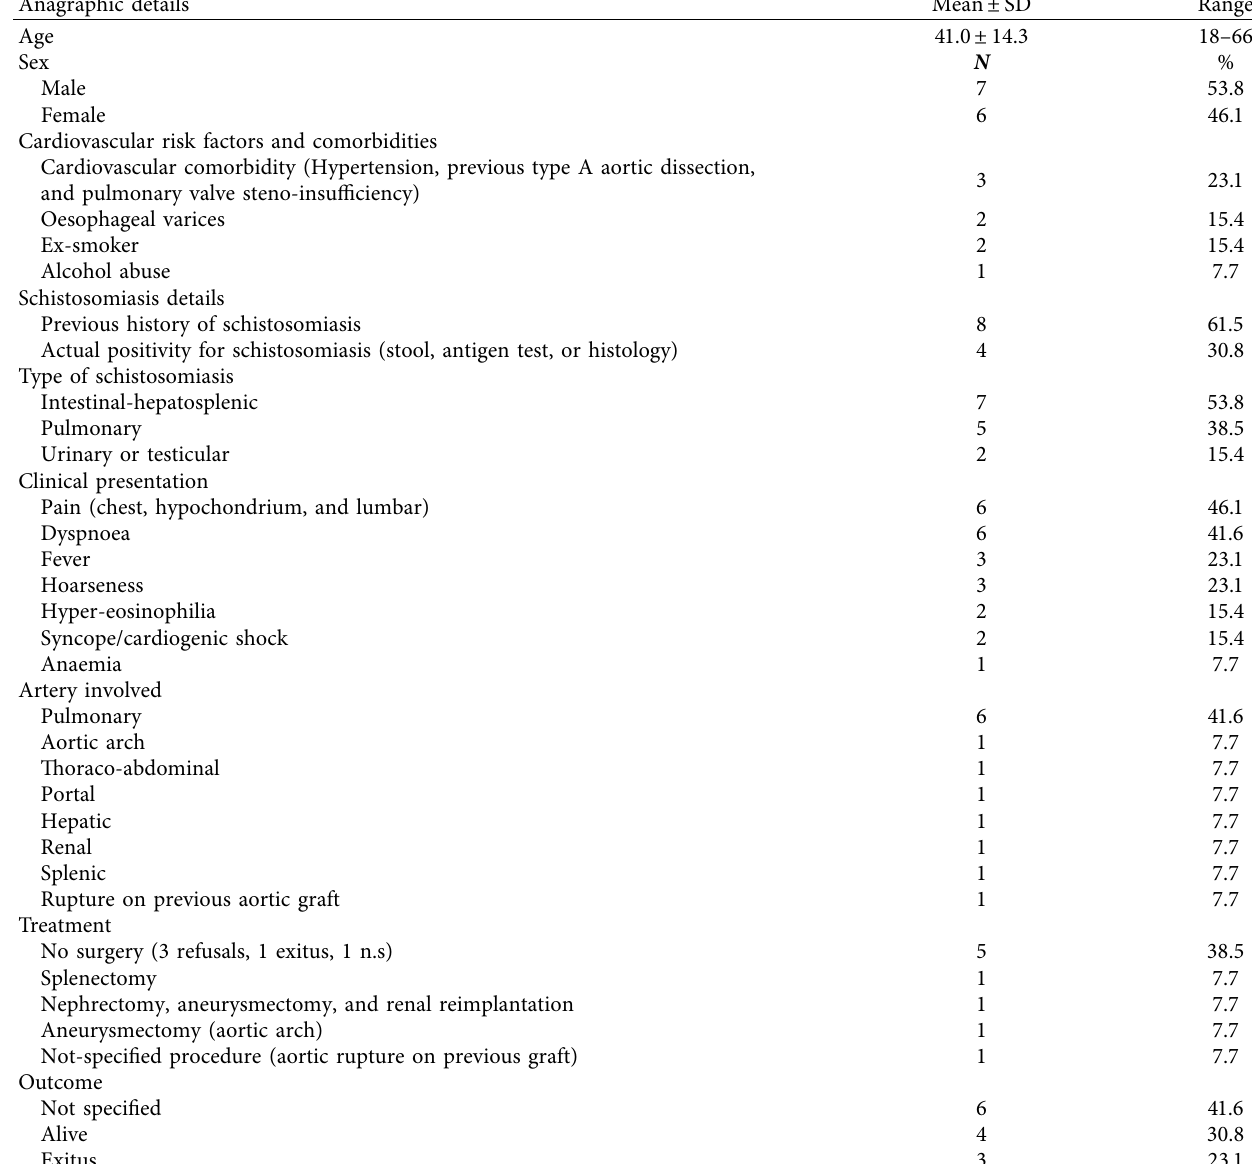
Table 4: Summary of fndings with frequencies and